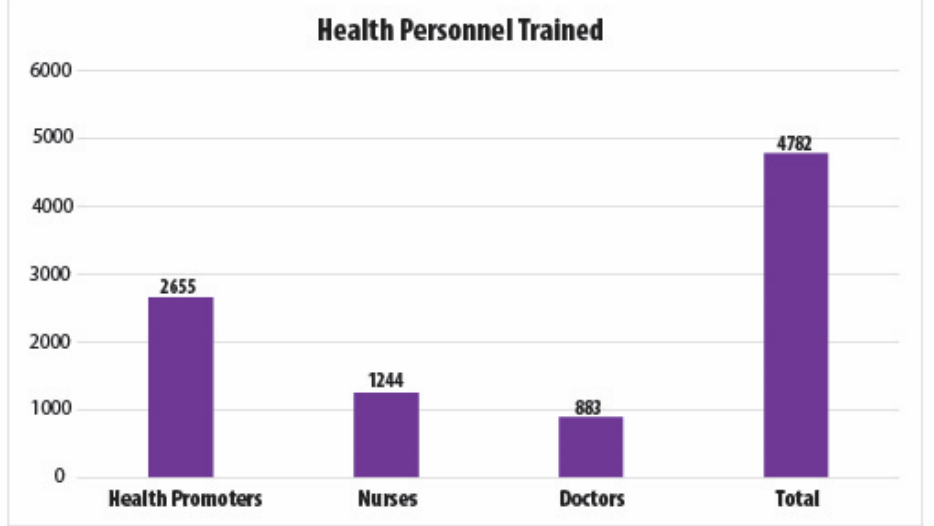
Figure 2. ECO team members trained in El Salvador as part of the national HPV screening pro- gram.